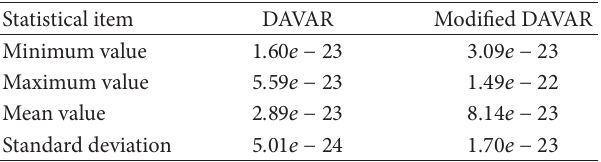
Table 5: Statistical characteristic of 𝜎 2 𝑖,𝑚 and 𝜐 2 𝑖,𝑚 .